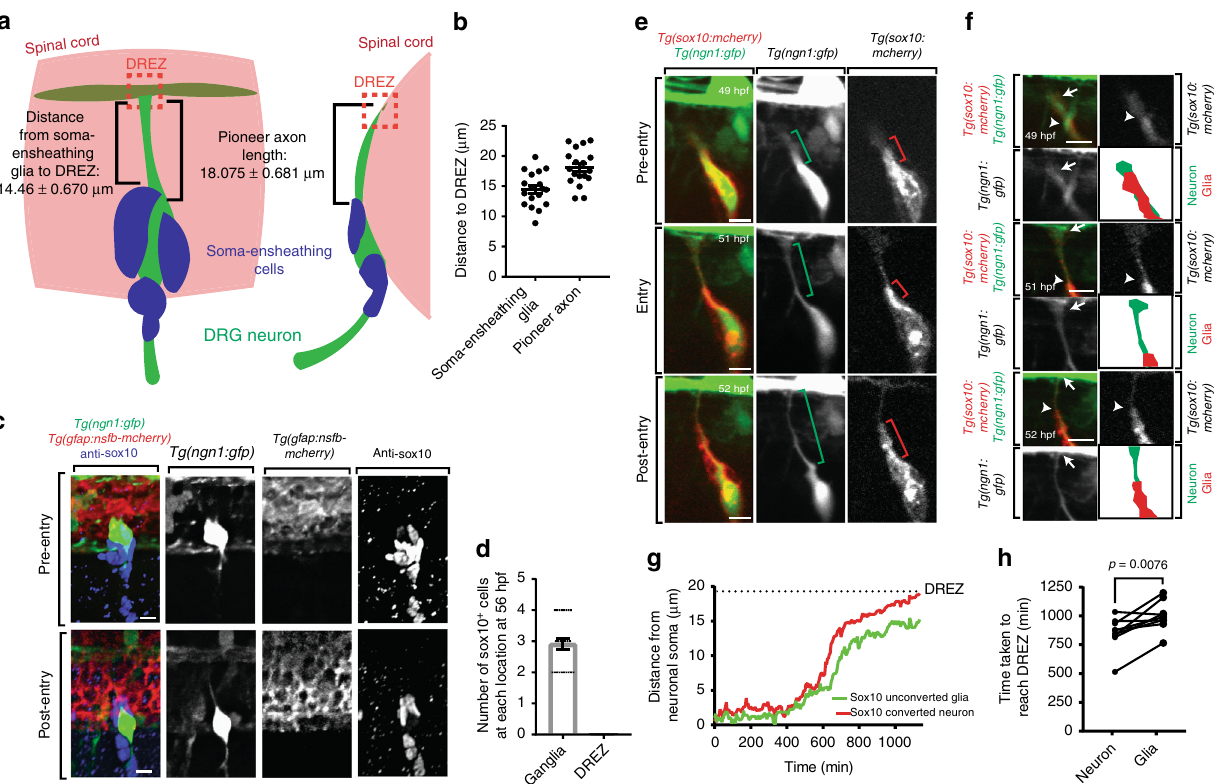
Fig. 1 Sensory pioneer axons contact the dorsal root entry zone (DREZ) before arrival of boundary cap cells. a Diagram of the dorsal root ganglia (DRG) and DREZ following pioneer axon entry. Measurements are taken from ( b ). b Distance from the soma-ensheathing glia to the DREZ and length of the pioneer axon at 72 h post fertilization (hpf). c Confocal z -projection frames of a Tg(ngn1:gfp); Tg(gfap:nsfb-mcherry) zebra fi sh stained for Sox10 at 56 hpf showing absence of Sox10 staining at the DREZ. d Quanti fi cation of the number of Sox10 + cell bodies located in the DRG and at the DREZ at 56 hpf. SEM is shown, n = 25 DRG. e Confocal z -projection frames from a 24-h time-lapse starting at 48 hpf of a Tg(sox10:gal4); Tg(uas:mcherry); Tg(ngn1:gfp) animal before, during, and after pioneer axon entry. The mCherry + /GFP - glia do not extend with the mCherry + /GFP + neuron to the DREZ. Green brackets denote length of axon. Red brackets denote length of glia. f Growth cone insets and rendering from ( e ) con fi rming absence of glial processes at the DREZ. White arrows denote growth cone. White arrowheads denote glial leading edge. Green drawing denotes axon tracing. Red drawing denotes glial tracing. g Quanti fi cation of the distance between the pioneer axon (red) and associated glia (green) during axon extension, demonstrating DREZ contact by the pioneer axon before glial DREZ arrival. Dashed black line denotes the location of the DREZ. h Quanti fi cation of the time between axon initiation and axonal or glial contact of the DREZ. The axon consistently contacts the DREZ before associated glia, n = 9 DRG. Unpaired Student ’ s t- test ( h ). Scale bars denote 10 µ (Supplementary Figure 1b). The totality of these complementary data are inconsistent with a model that pioneer axon ingrowth at the DREZ is dependent on neural crest cells.